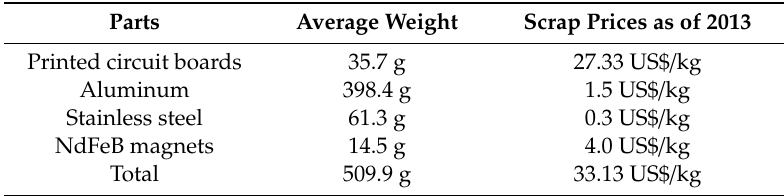
Table 1. Average material composition and scrap prices of hard disk drives